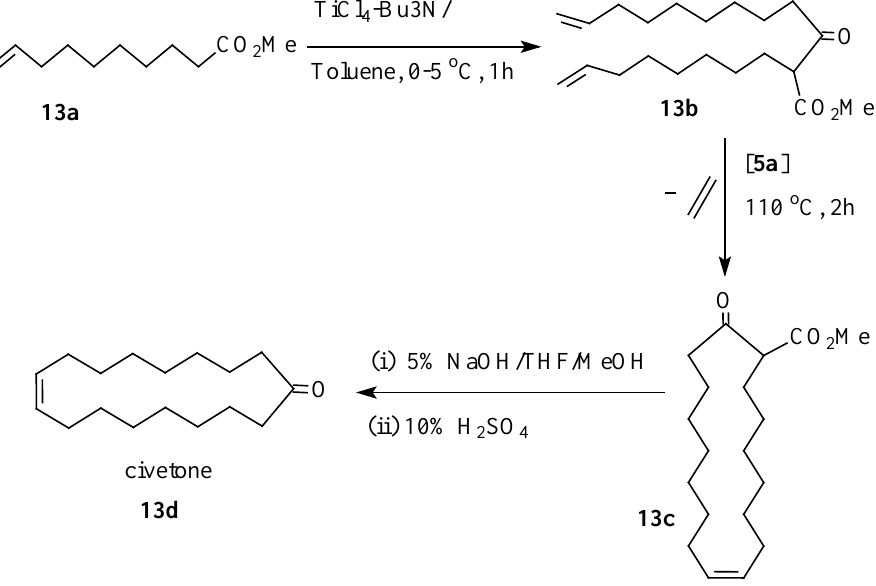
Scheme 6. Synthesis of civetone via Ti-Claisen condensation and RCM.